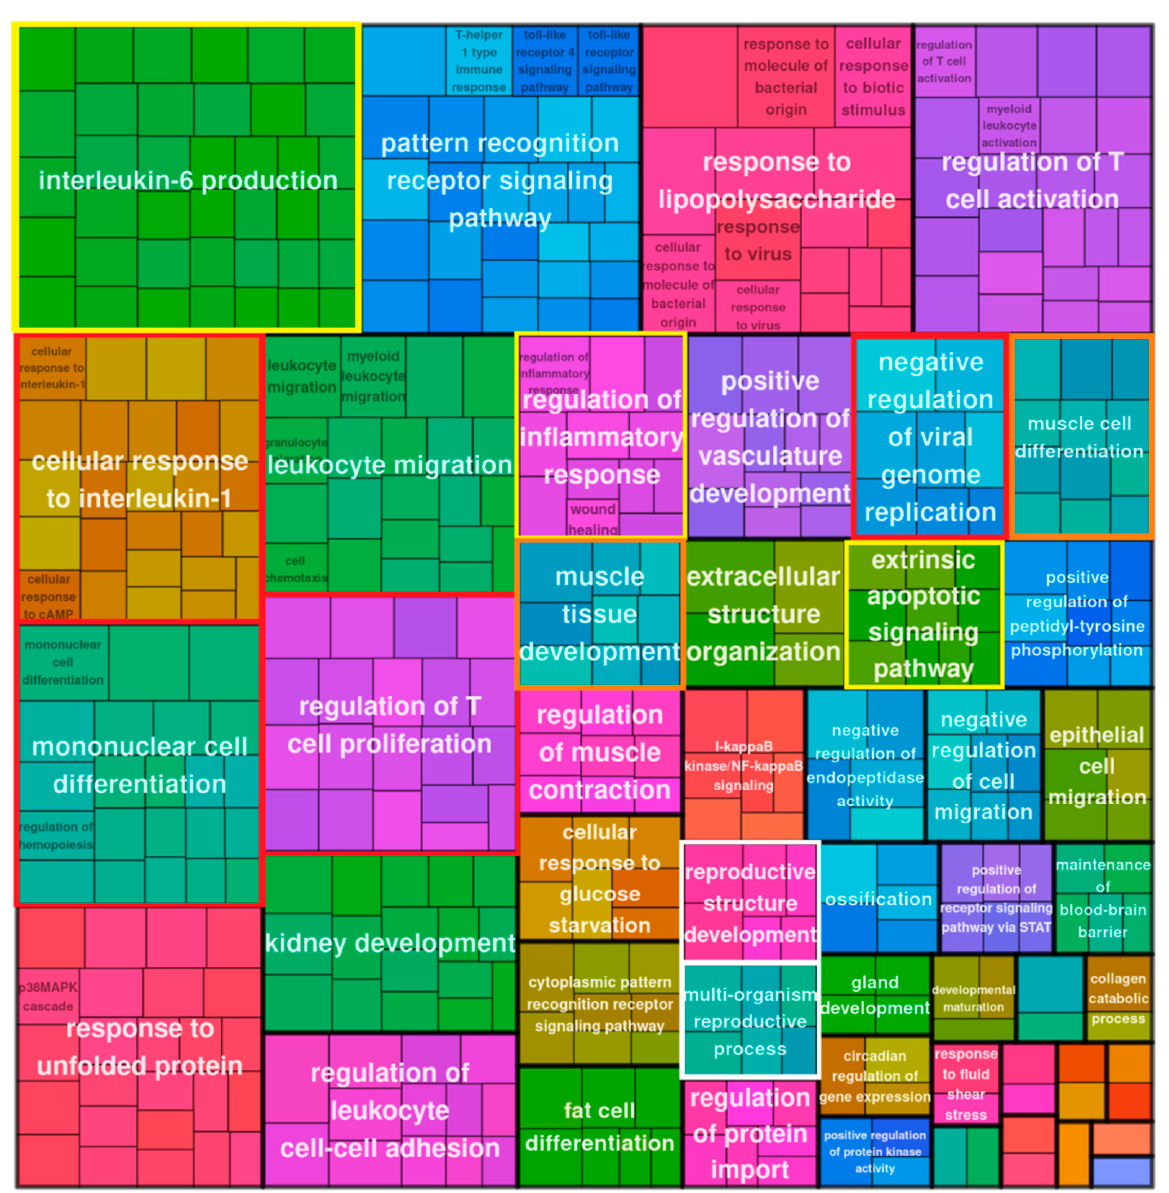
Figure 5. Treemap plot representation of the GO BP enrichment analysis results (GO modules with hypergeometric test pAdj < 0.05 classed as enriched) for all genes upregulated in MDA-MB-231 cells on day 16 post-DOX.